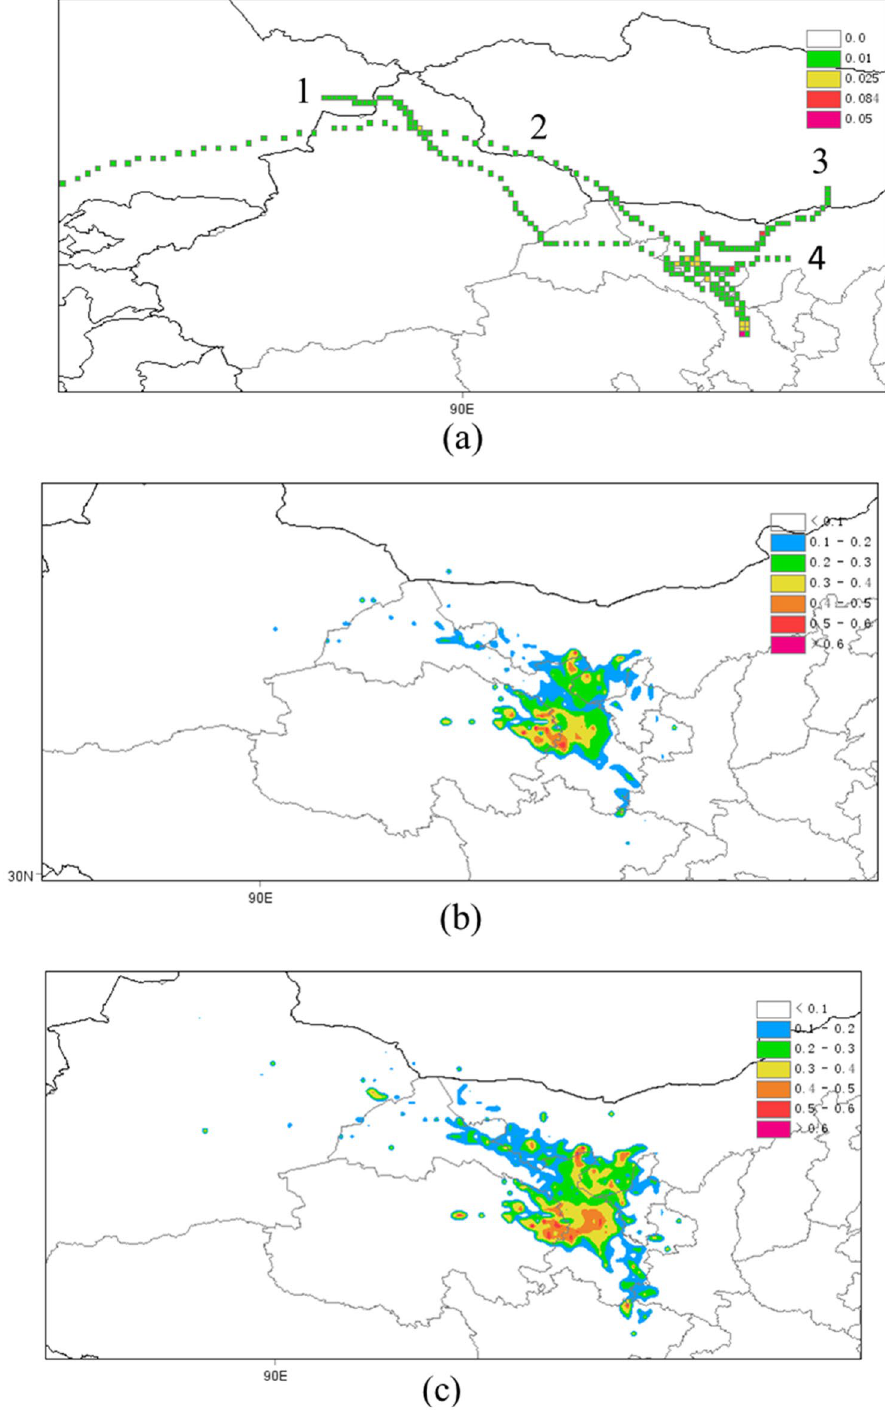
Figure 5. PSCF analysis for ( a ) dust storm days, ( b ) normal days, and ( c ) the entire spring in 2021 in Lanzhou, China (MeteoInfo 3.1.7 http:// www. meteo think. org/ downl oads/ index.